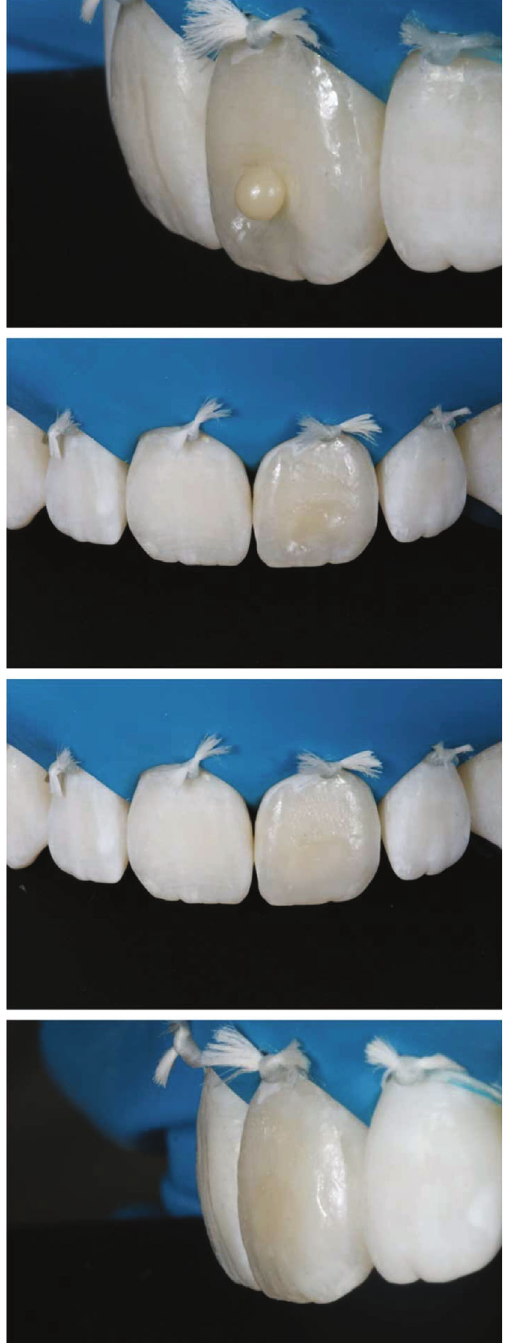
Figure 7: The fi rst increment of the composite resin was applied in the color LD Essentia-GC. Then, the resin color LE Essentia-GC was applied, corresponding to the enamel